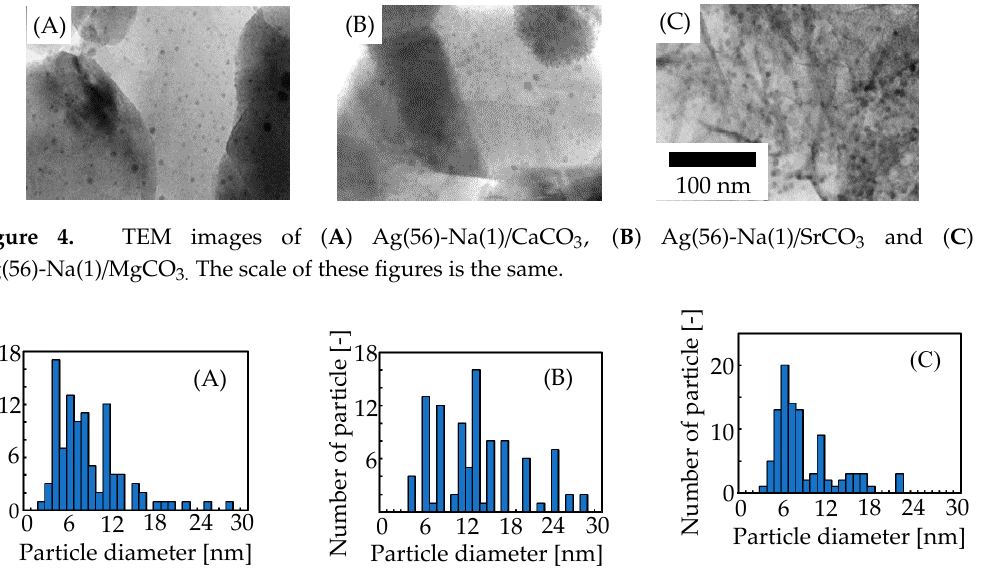
Figure 5. Particle size distribution of Ag on ( A ) Ag(56)-Na(1) / CaCO 3 , ( B ) Ag(56)-Na(1) / SrCO 3 , and ( C ) Ag(56)-Na(1) / MgCO 3 .